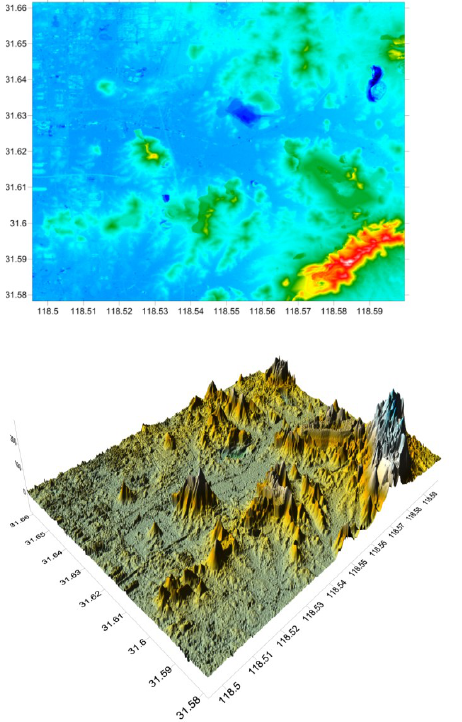
Figure 6 3D expression of DEM in Maanshan